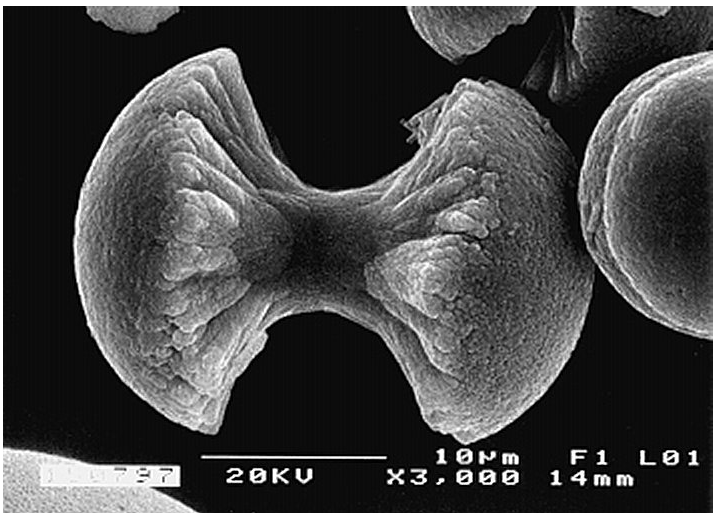
Figure 4. A biomimetically grown aggregate of FA that was crystallized in a gelatin matrix. Its shape can be explained and simulated by a fractal growth mechanism. Scale bar: 10 μ m (taken from Ref. [295] with